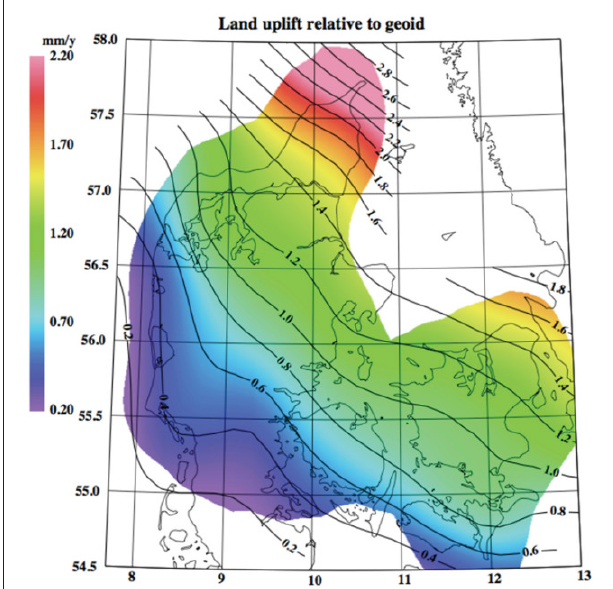
FIGURE 7 | The calculated land uplift rates for Denmark relative to the geoid .